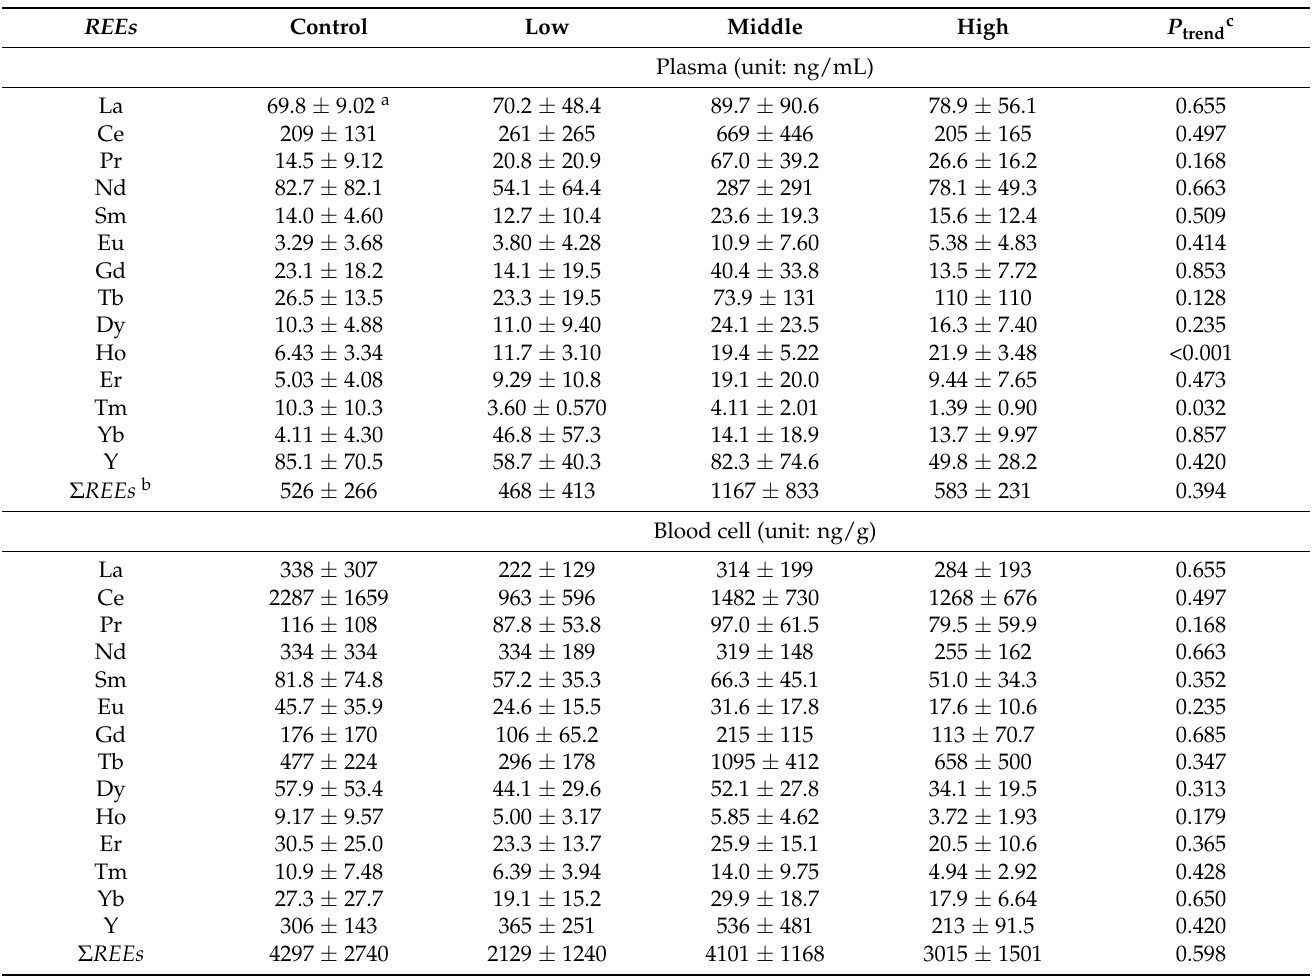
Table 2. The dose–response relationships between administration levels of 14 REEs to rats and their concentrations in rat plasma and blood cell